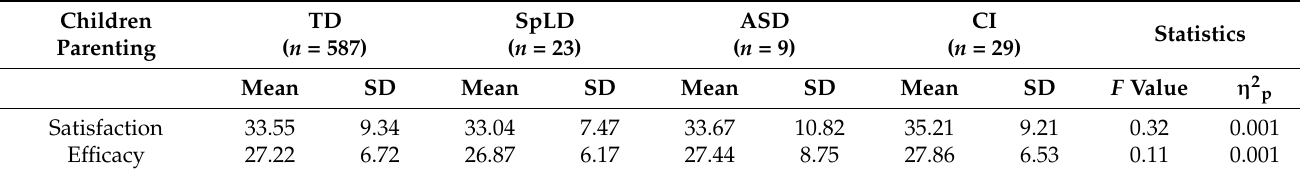
Table 3. Scores of parenting sense of competence.